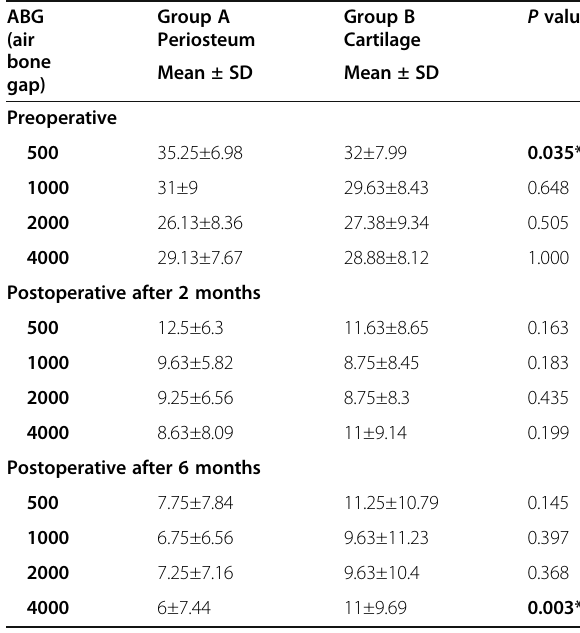
Table 3 Air-bone gap preoperative and 2 and 6 months